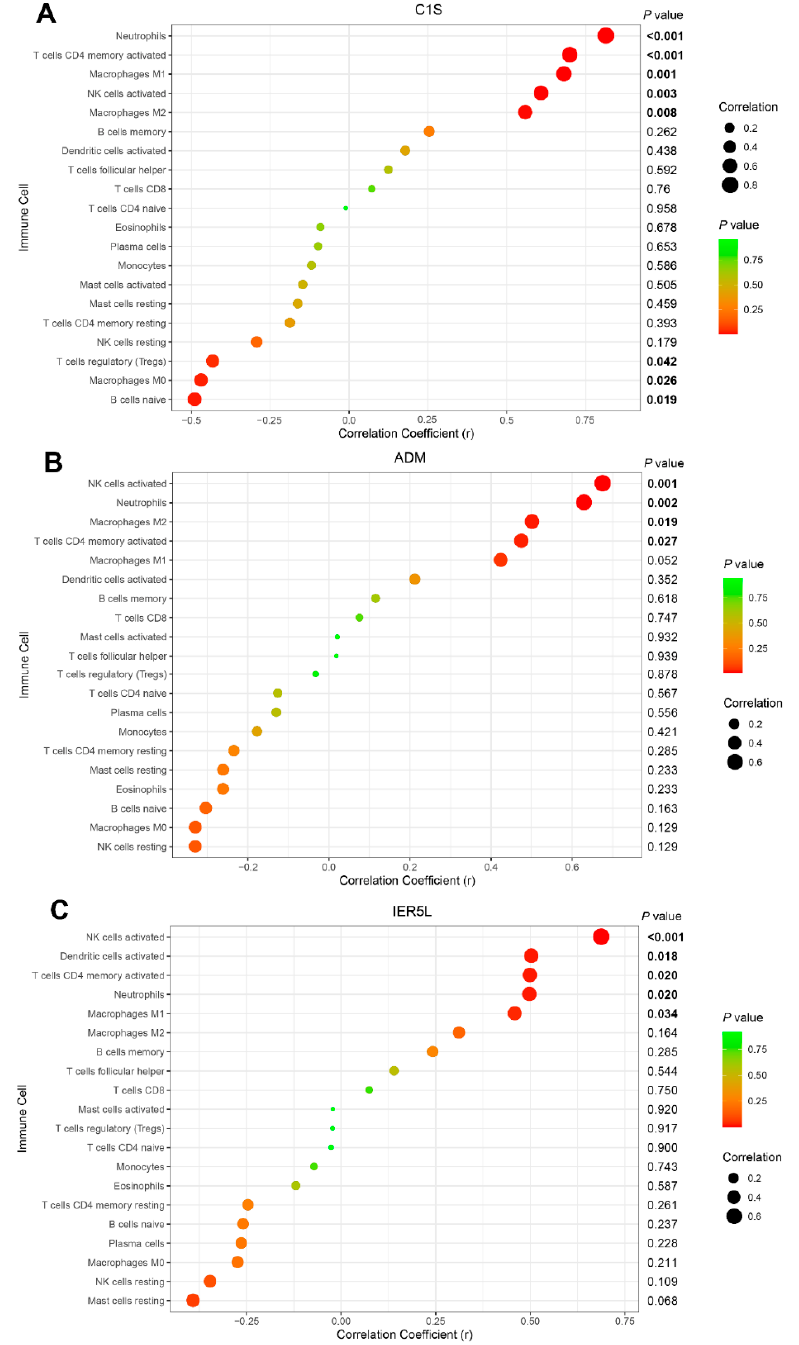
Figure 8. The correlation analysis between the infiltration levels of immune cells with C1S ( A ), ADM ( B ), and IER5L ( C ), respectively.